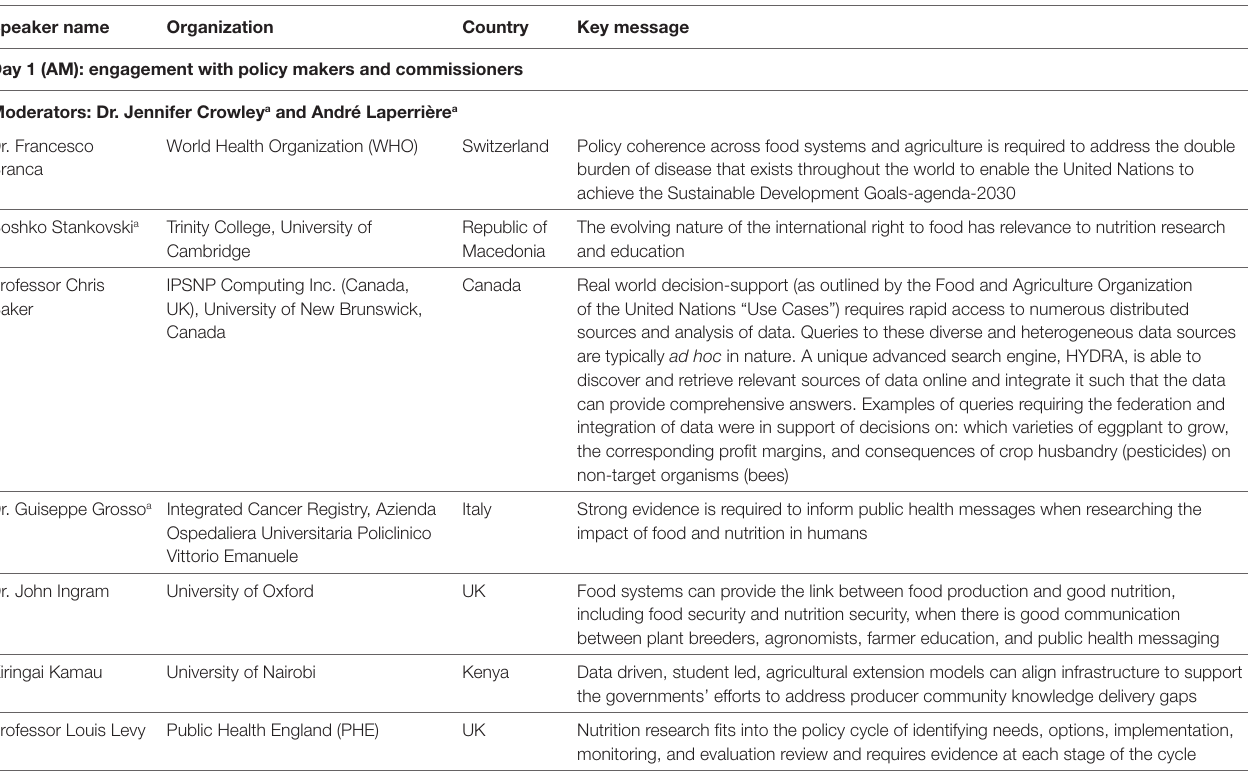
tAbLe 1 | Speakers and key messages from the Third International Summit on Medical Nutrition Education and